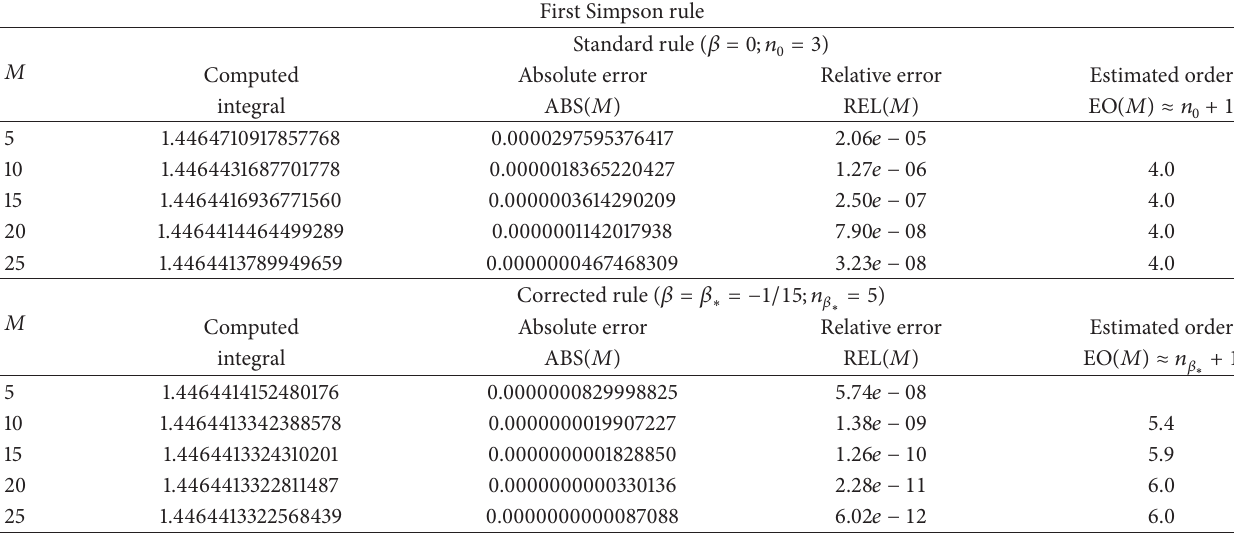
Table 6: Results for the first Simpson rule.